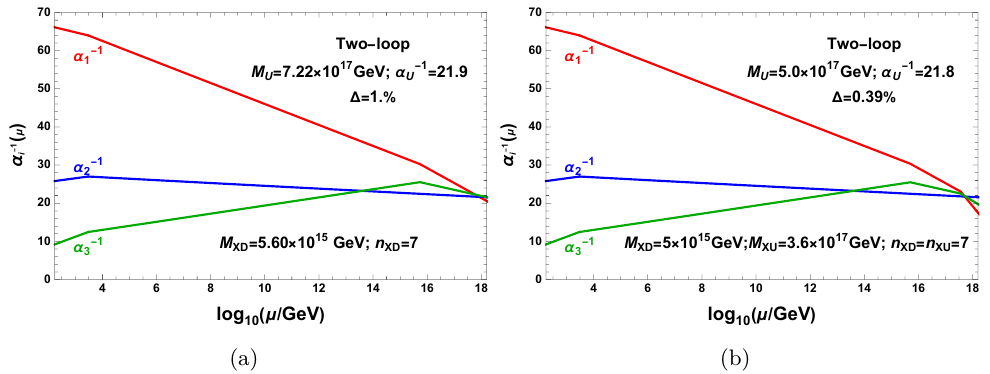
Figure 8 . Two-loop evolution of gauge couplings for the Model 15 with vector-like particles. In the model, k = 25 × 5 and k = 7 . The string-scale gauge coupling relation can be achieved by Y 2 28 3 6 adding 7( XD + XD ) (a) as well as 7( XU + XE ) (b).